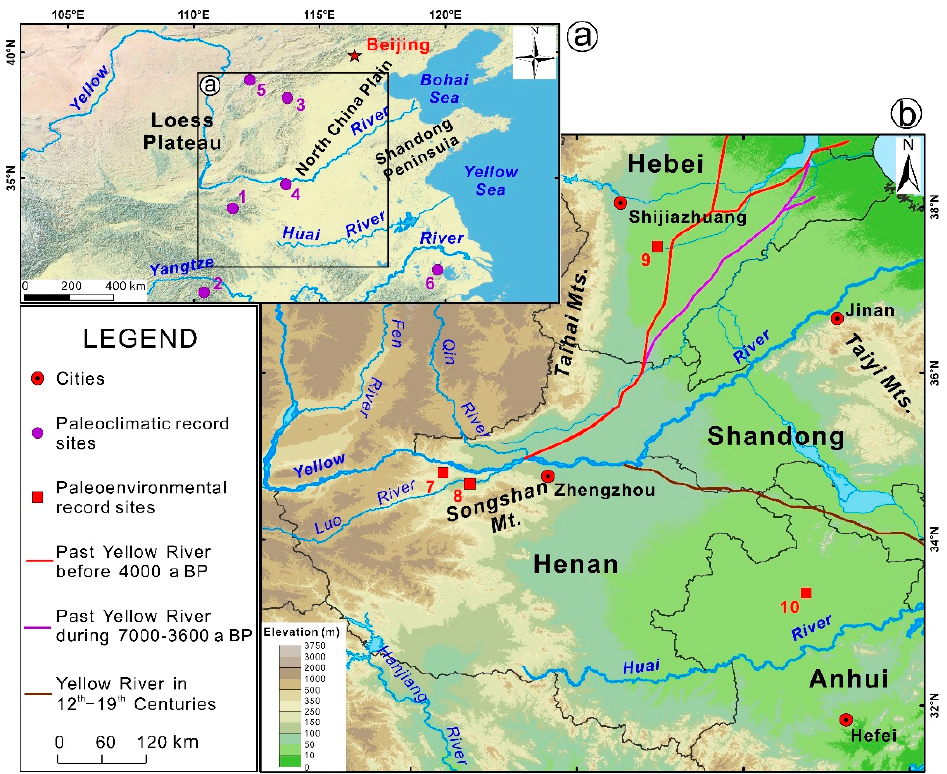
Figure 1. Study area. ( a ) The large-scale geographic context of the lower Yellow River floodplain. The labels are high-resolution paleoclimatic record sites (purple circles, No. 1–5) in the lower Yellow River floodplain and the surrounding areas, and they are as follows: 1. Dongshiya Cave [47], 2. Heshang Cave [48], 3. Lianhua Cave [49], 4. Zhengzhou City [50], 5. Gonghai Lake [51], and 6. Xinjie Profile (a lacustrine sequence) [52]. ( b ) Topographical background of the lower Yellow River floodplain and the surrounding areas and the locations of the modern Yellow River course, historic Yellow River course (12th-19th centuries) [75] and the Yellow River course during the pre-Longshan and Longshan periods. The red line is the inferred river course before ~4000 a BP from documentary records [46], and the purple line is the inferred river course between ~7000 and ~3600 a BP from 157 boreholes [77]. In addition, local sites of paleoenvironmental records in the study area are also shown (red boxes, No. 7–10), including 7. Sihenan strata [53,54], 8. Wuchagou strata [55], 9. Ningjinpo strata [56], 10. Yuchisi strata